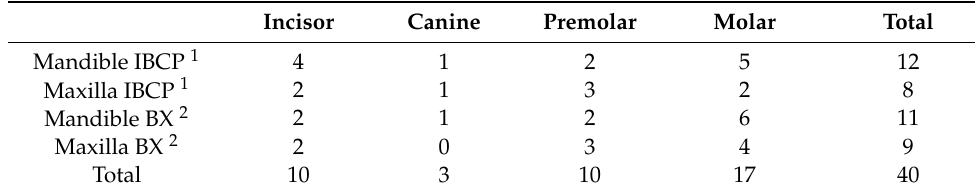
Table 2. Distribution of extraction sites. Incisor Canine Premolar Molar